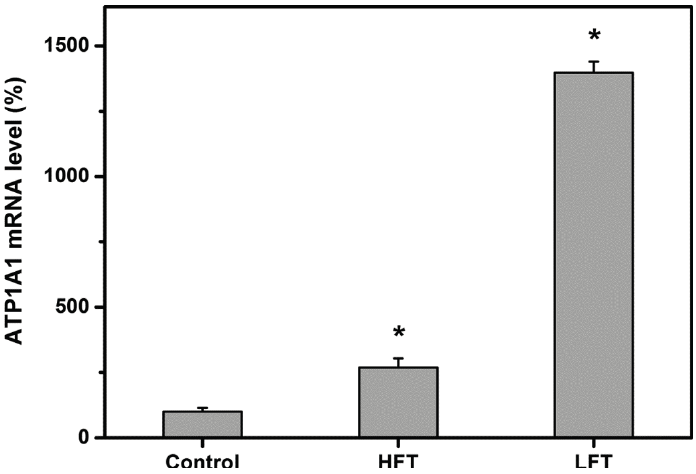
Figure 6. Gene expression level of ATP1A1 in rabbit CECs after 8 h of direct contact with various HA carriers, measured by real-time reverse transcription polymerase chain reaction. Normalization was done by using GAPDH. Data in the experimental groups are percentages relative to that of control groups (cells cultured in the absence of HA materials). An asterisk indicates statistically-significant differences ( * p < 0.05; n = 4) as compared to the control